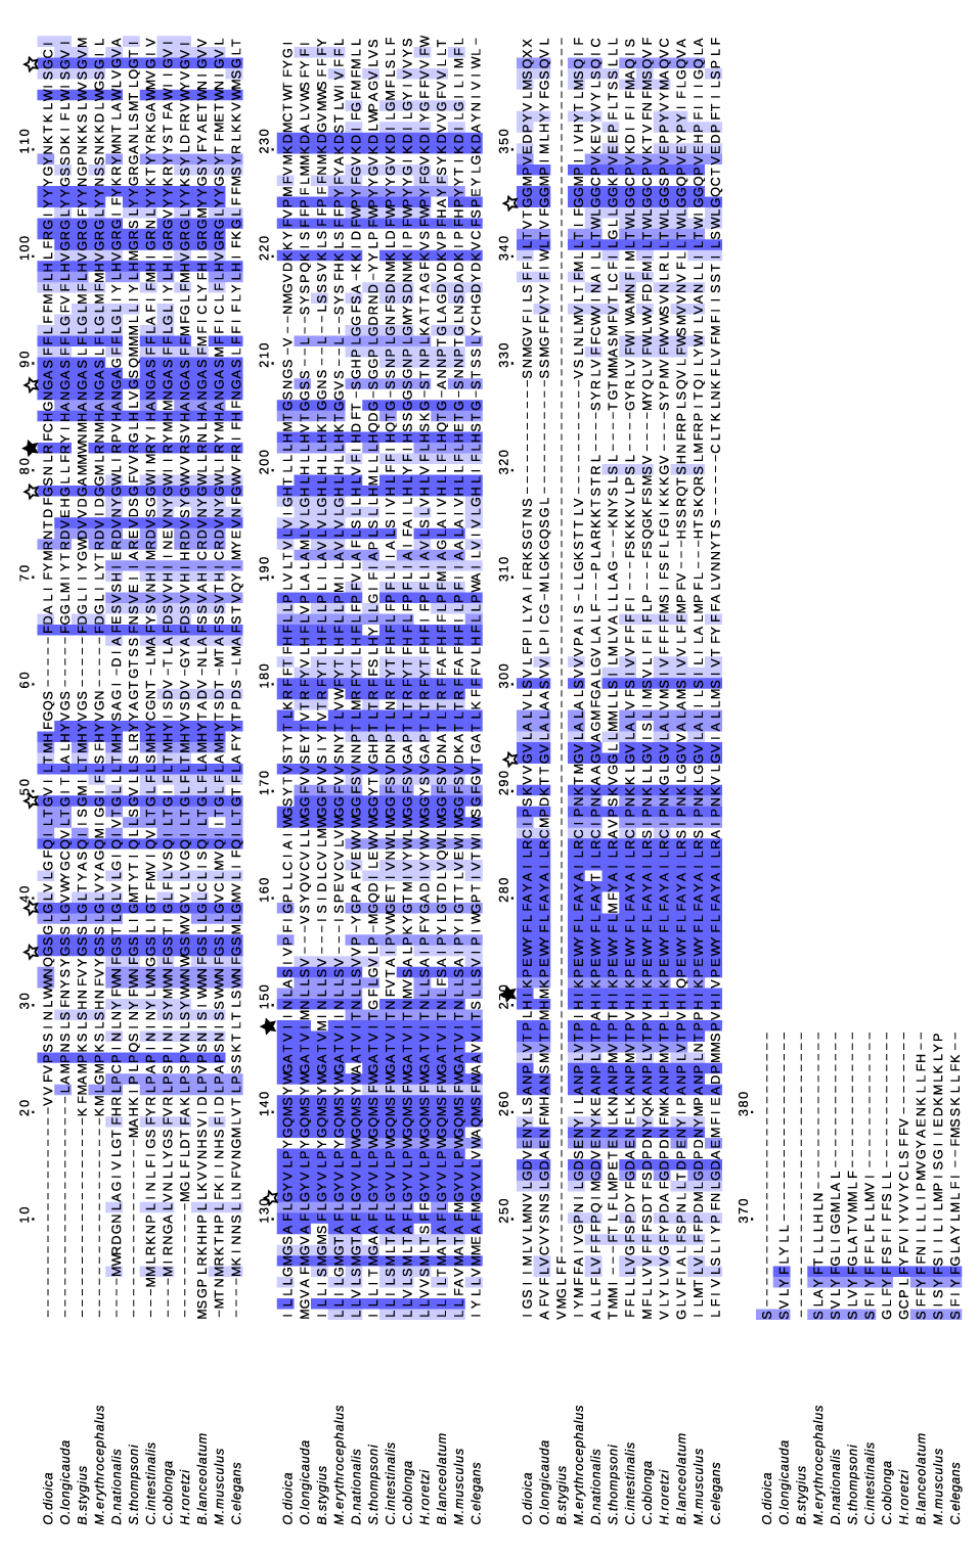
Figure 3. Sequence alignment of Cob proteins. White stars indicate conserved cysteines when at least one tunicate uses an AGR codon. Black stars indicate positions suggesting a different genetic